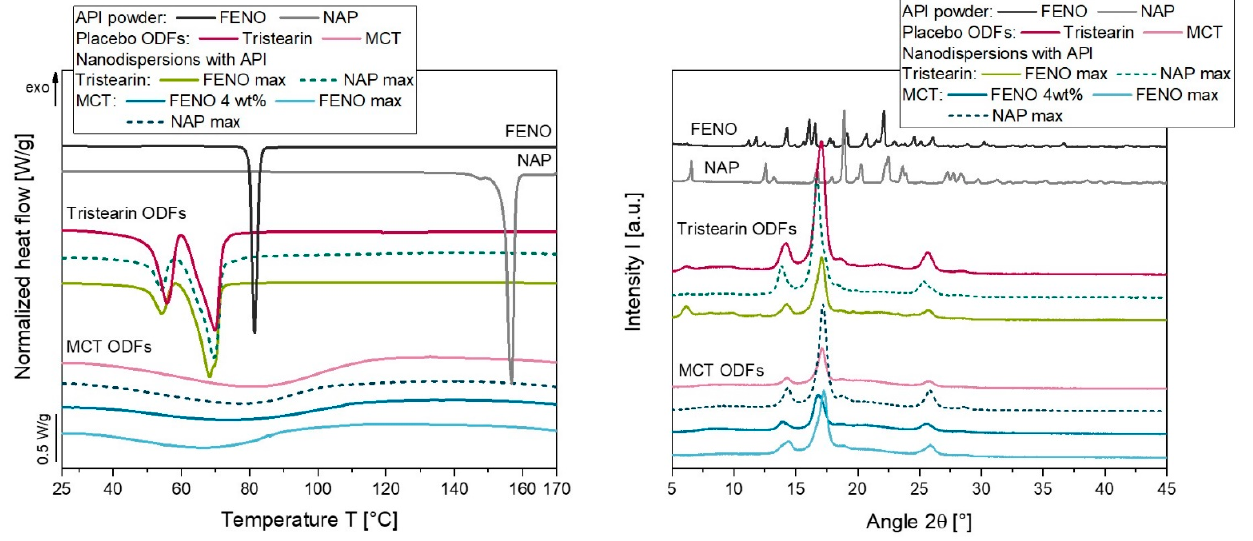
Figure 6. DSC melting curve ( left ) and XRD diffractograms ( right ) of API loaded lipid-containing ODFs. The DSC curves were normalized to the sample mass and the lipid content of the respective formulation for better visualization.